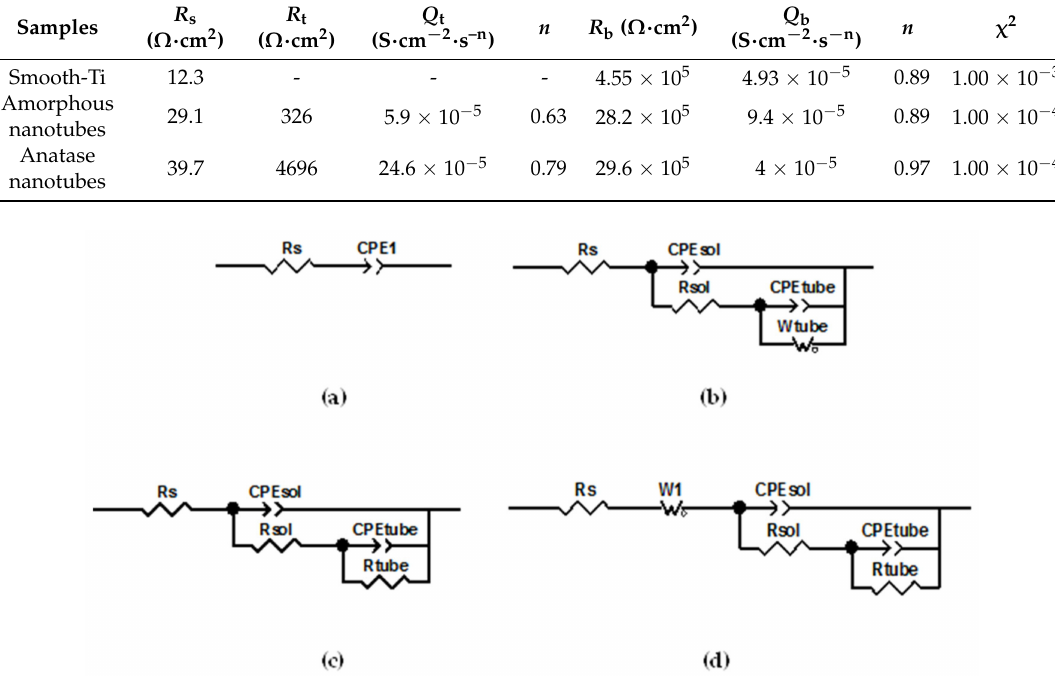
Figure 4. Equivalent circuit model of ( a ) titanium original, ( b ) amorphous nanotubes, ( c ) anatase nanotubes after 1 day of immersion, ( d ) anatase nanotubes after two weeks of immersion